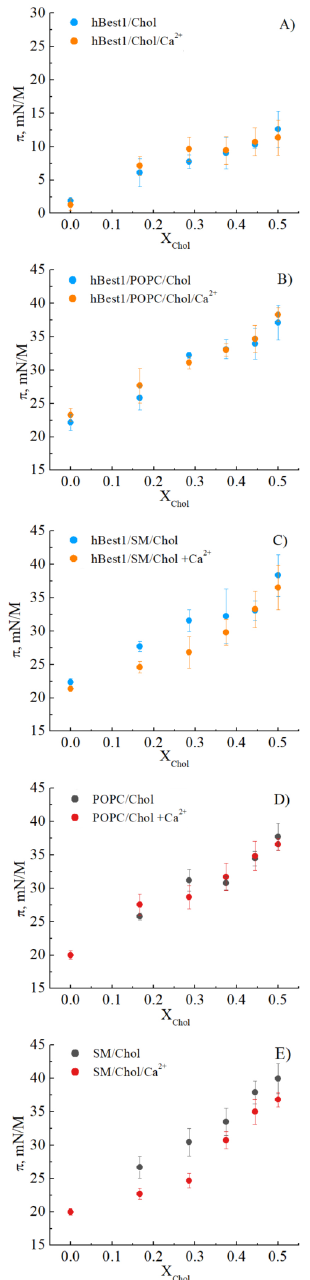
Figure 1. Condensing effect of cholesterol on ( A ) hBest1, ( B ) hBest1/POPC, ( C ) hBest1/SM, ( D ) POPC and ( E ) SM monolayers (at molar fractions of Chol 0.167; 0.285; 0.375; 0.444 and 0.5) in the presence or absence of Ca 2+ , at 35 ± 2 °C. Data are presented as mean ± SE, n = 7.